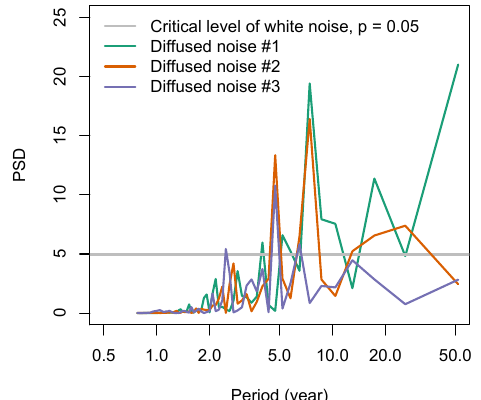
Figure B1. Demonstration of spurious peaks when testing against a white noise null hypothesis. Coloured lines show power spectra for three realisations of purely random firn profiles. The grey hor- izontal line shows the critical level ( p = 0 . 05) that has to be over- come to be locally significant against white noise. As the simulated firn profiles are subject to firn diffusion, and thus have a red power spectrum, they show random peaks higher than the critical